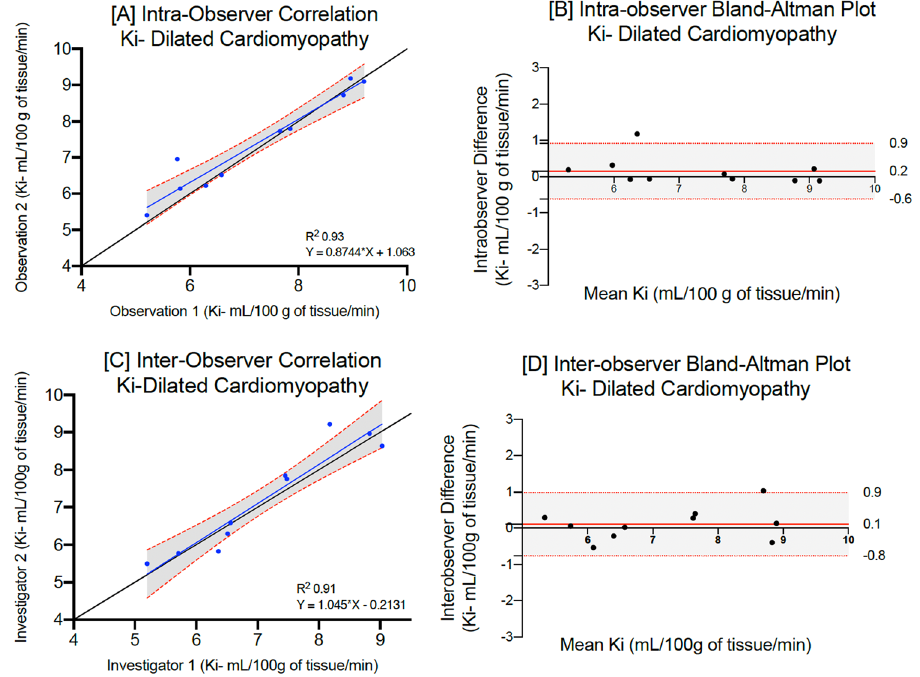
Figure 5. Intraobserver and interobserver repeatability of myocardial manganese uptake in dilated cardiomyopathy. Intra-observer linear regression analysis ( A ) and Bland–Altman plots for myocardial